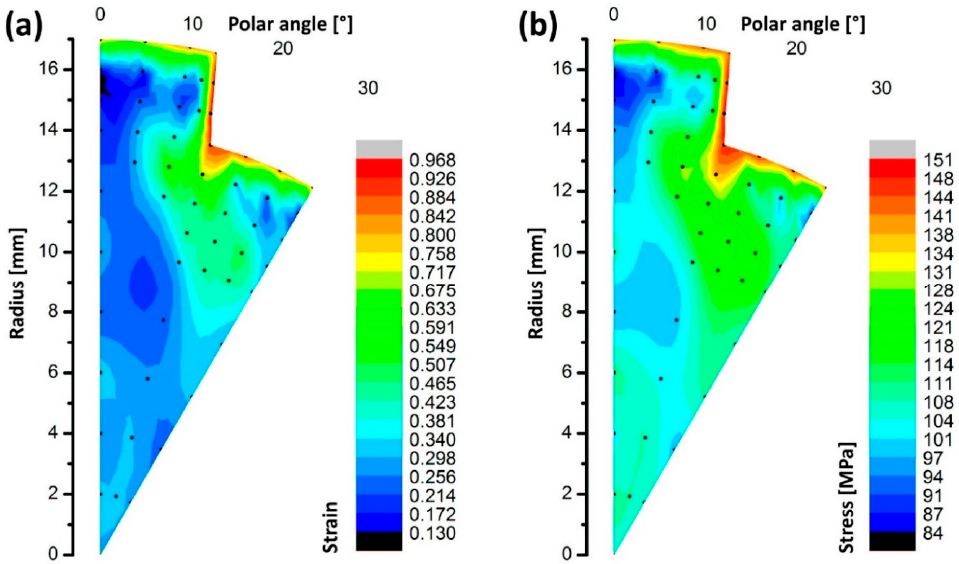
Figure 11. Strain ( a ) and stress ( b ) state in the 30° segment of the gear-like element (black dots represent the position of strain/stress calculation based on grain size measurements from Figure 8b; OriginPro8.6, Polar Contour Plot).